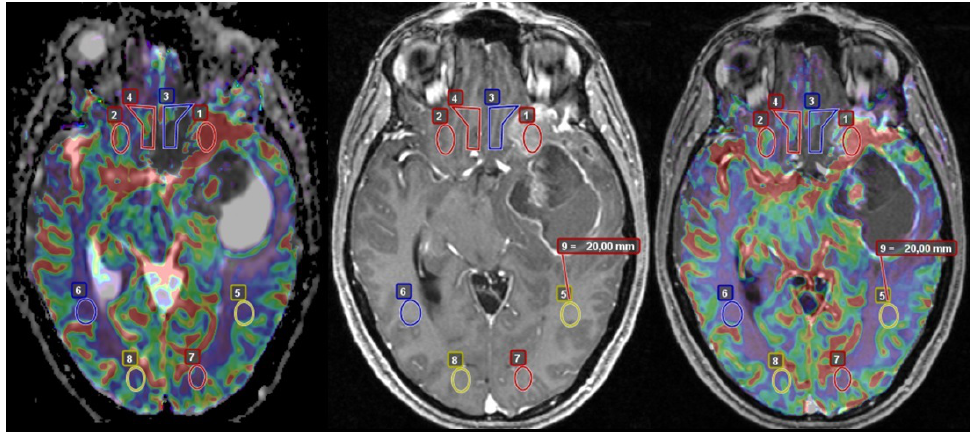
Figure 1. Defined regions of interest in a representative case. Overlay images were acquired in Olea ©. From left to right: Overlay of DSC perfusion and ADC maps; T1 MPRAGE post-contrast administration; and overlay of T1 MPRAGE post-contrast administration and DSC perfusion.